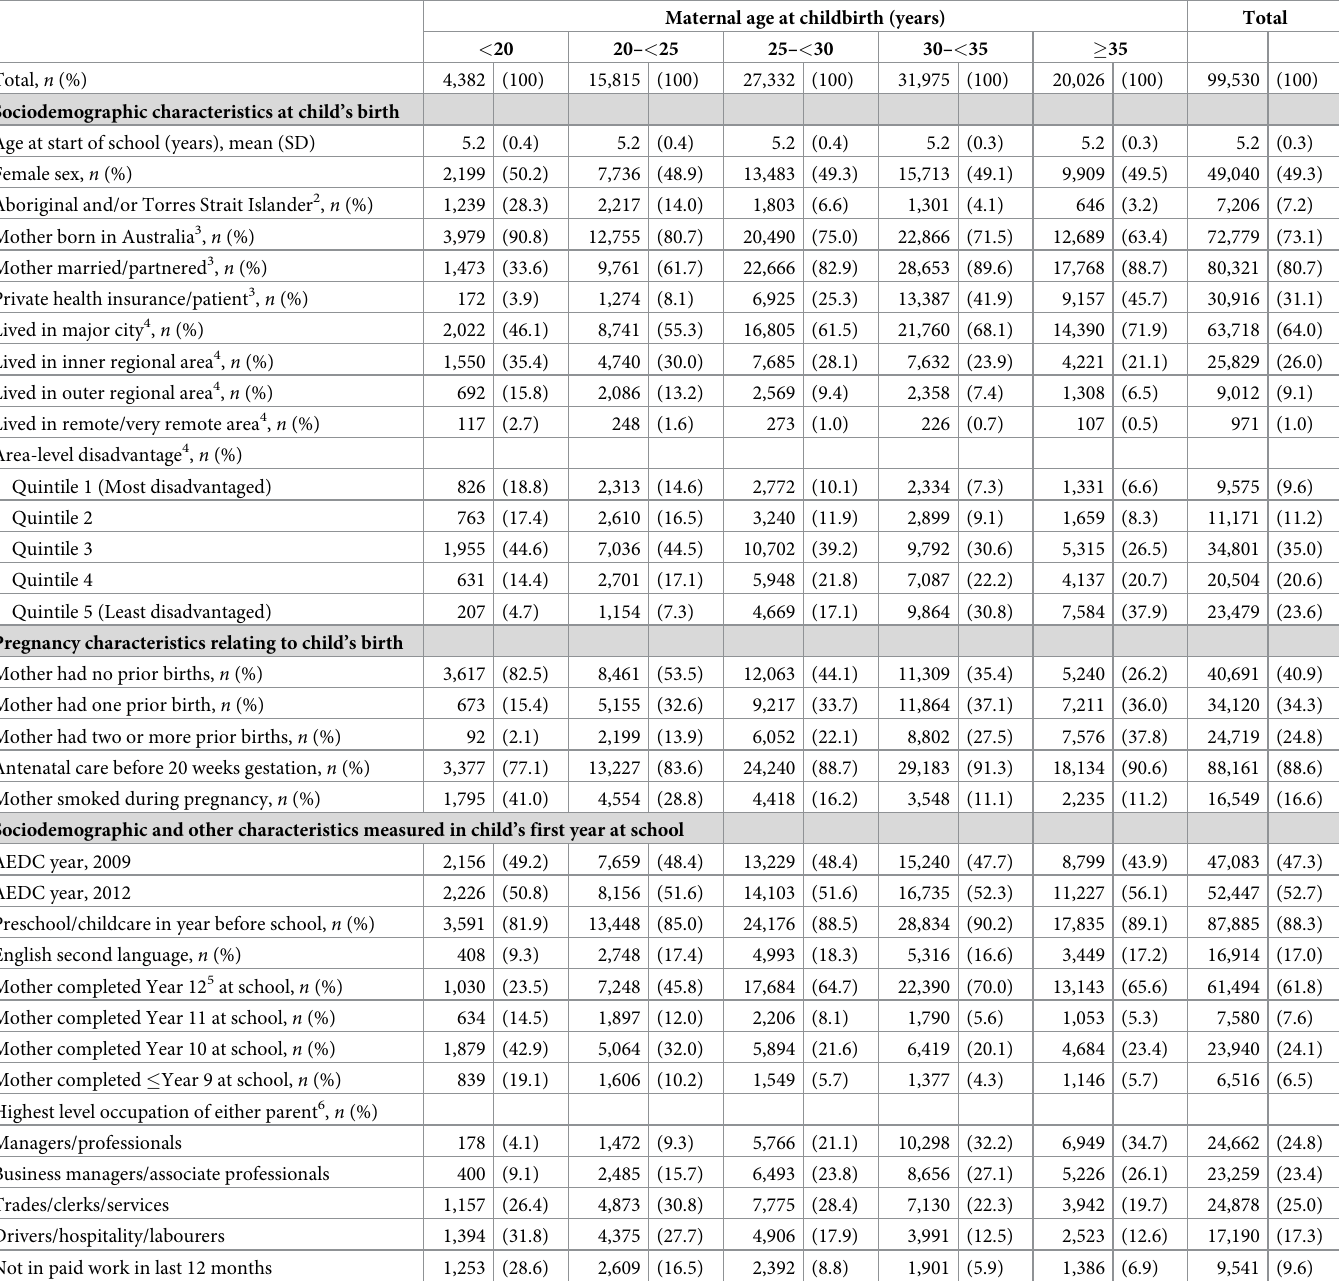
Table 1. Sociodemographic, pregnancy, and early childhood characteristics, by maternal age at childbirth, for the 99,530 children in the study population 1 . Maternal age at childbirth